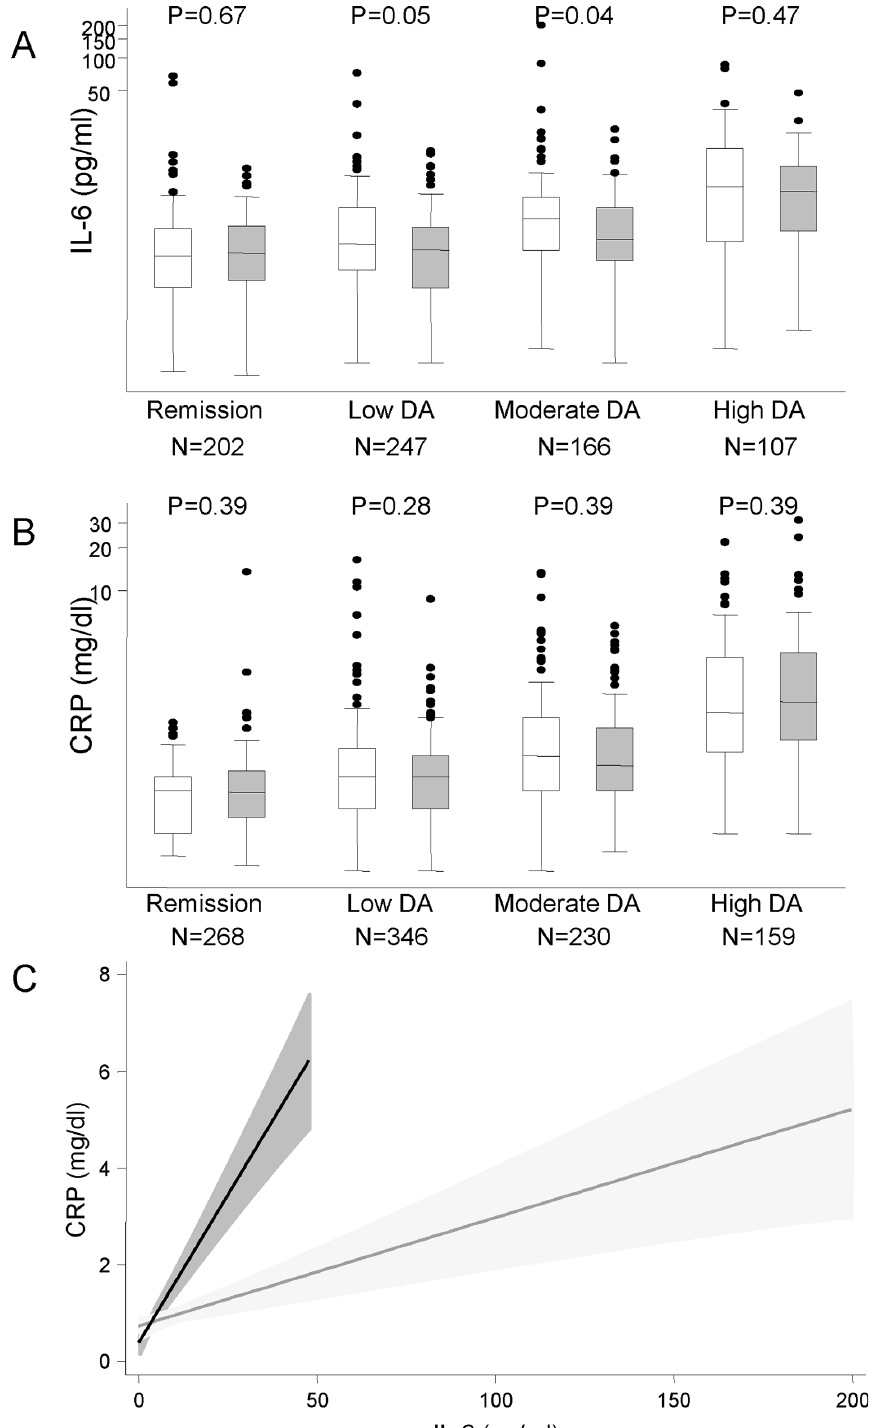
Fig 5. Interleukin-6 (IL-6) induces higher levels of C reactive protein in patients with, at least one T allele of rs7574865. IL-6 (panel A) and C-reactive protein (B panel) serum levels in patients with early arthritis clustered by disease activity level and rs7574865 genotype (white boxes GG genotype, grey boxes GT and TT genotypes). Data are shown as the interquartile range (p75 upper edge of the box, p25 lower edge, p50 midline), as well as the p95 (line above the box) and p5(line below the box). Dots